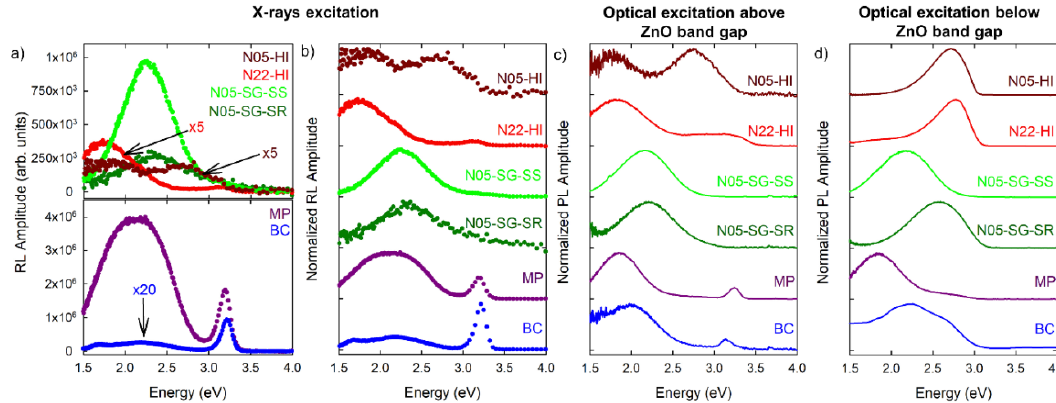
Figure 3. Optical properties of different ZnO materials: ( a , b ) Room temperature (RT) radioluminescence (RL) intensities and normalized RL spectra under X-ray irradiation, respectively; for all samples the spectra are measured at 300 K and 10 −3 mbar pressure, operating the X-ray tube at 20 kV and 20 mA; ( c ) Normalized photoluminescence (PL) spectra of all samples recorded under continuous wave (CW) excitation at 3.5–3.6 eV (above ZnO band gap) with the use of a long-pass filter with cutting wavelength at 370 nm (3.4 eV); ( d ) Normalized PL spectra of all samples recorded under CW excitation at 3.1–3.2 eV (below ZnO band gap) with the use of a long-pass filter with cutting wavelength at 418 nm (3.0 eV).